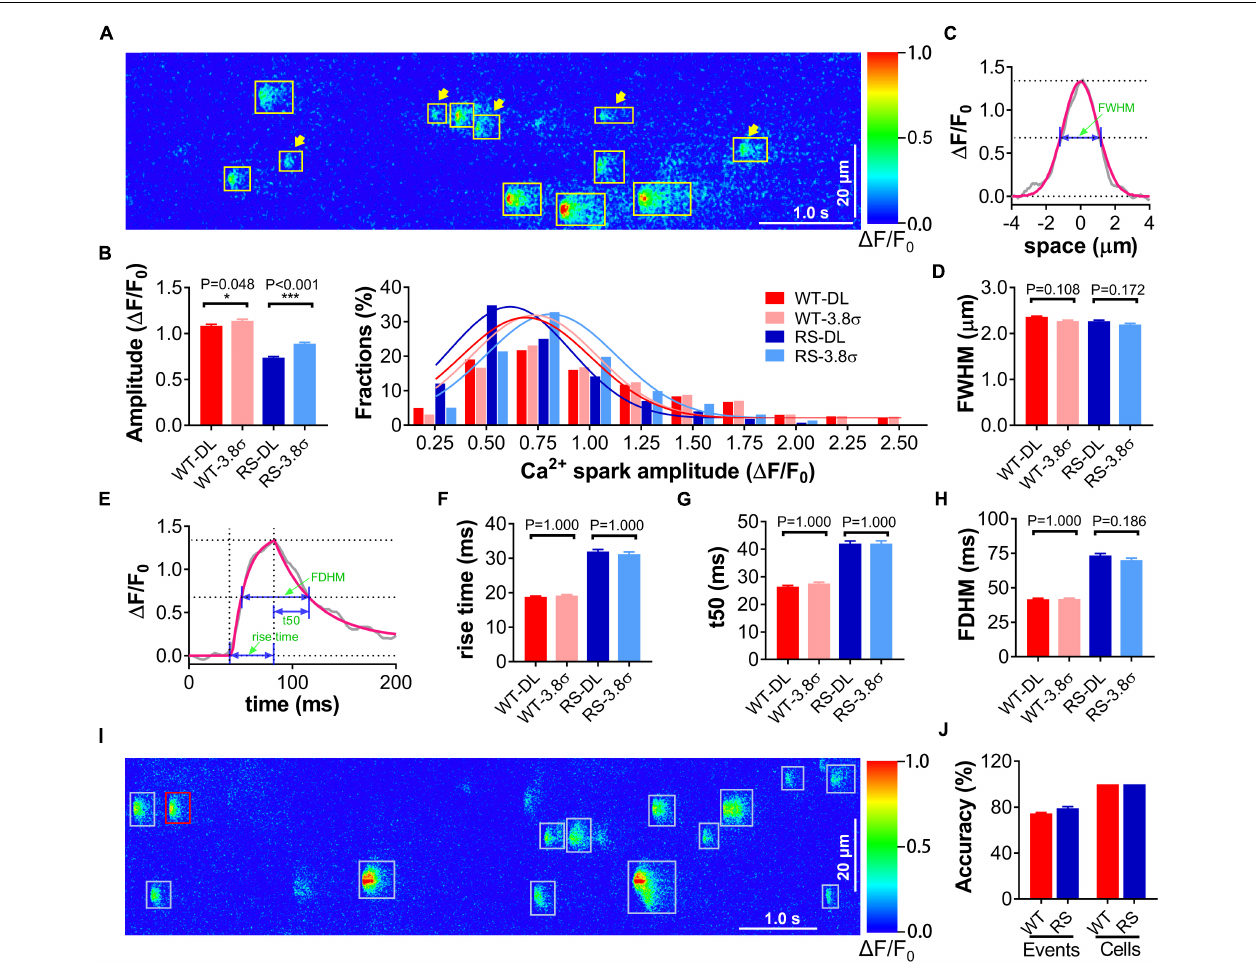
FIGURE 2 | Application of proposed method for spark detection and event-based classification of single cardiomyocytes using Ca 2 + spark characteristics. (A) An example of Ca 2 + sparks in a line-scan image of an RS cardiomyocyte detected by deep-learning methods. All detected sparks are labeled with rectangles, and the arrowheads indicate low-amplitude events (peak F / F 0 < µ + 3.8 σ ). (B) Statistics and distributions of Ca 2 + spark amplitude in WT and RS cardiomyocytes using conventional (3.8 σ ) and deep learning (DL) method. (C) Raw (gray)/Gaussian fitting (red) spatial traces of a representative Ca 2 + spark. FWHM is calculated from the fitting curve as illustrated. (D) Statistics of FWHM of Ca 2 + sparks in each group. (E) Raw (black)/fitting (Lacampagne et al., 1999) (red) time courses of a representative Ca 2 + spark. Rise time, t 50, and FDHM are calculated from the fitting curve as illustrated. (F–H) Statistics of temporal parameters of Ca 2 + sparks in each group. n = 1353 (DL)/1281 (3.8 σ ) or 1061 (DL)/807 (3.8 σ ) events in 108 WT or 52 RS cardiomyocytes. (I) An example of spark classification in a line-scan Ca 2 + image of an RS cardiomyocyte and (J) statistics of event- and cell-classification accuracy in the independent test dataset comprising 46 WT and 30